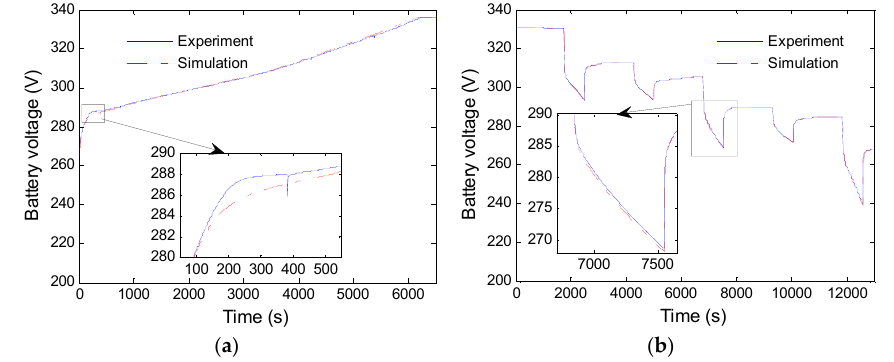
Figure 8. Verification of the battery pack model: ( a ) Experimental and simulation charge curves under constant current/constant voltage (CC/CV) charging mode; ( b ) Experiment and simulation discharge curves under 0.5 C/1 C discharging mode.